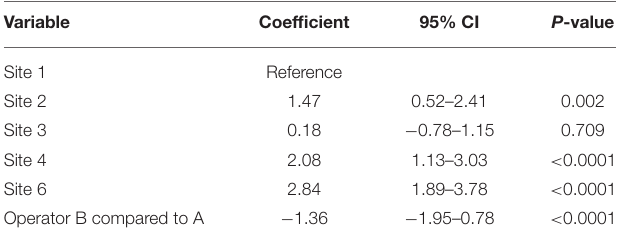
TABLE 2 | Results from a multivariable mixed effects model accounting for censoring (metobit), showing that the site at which the pressure algometer was applied, the operator and calf identity significantly affected the MNT measured over the thoraces of